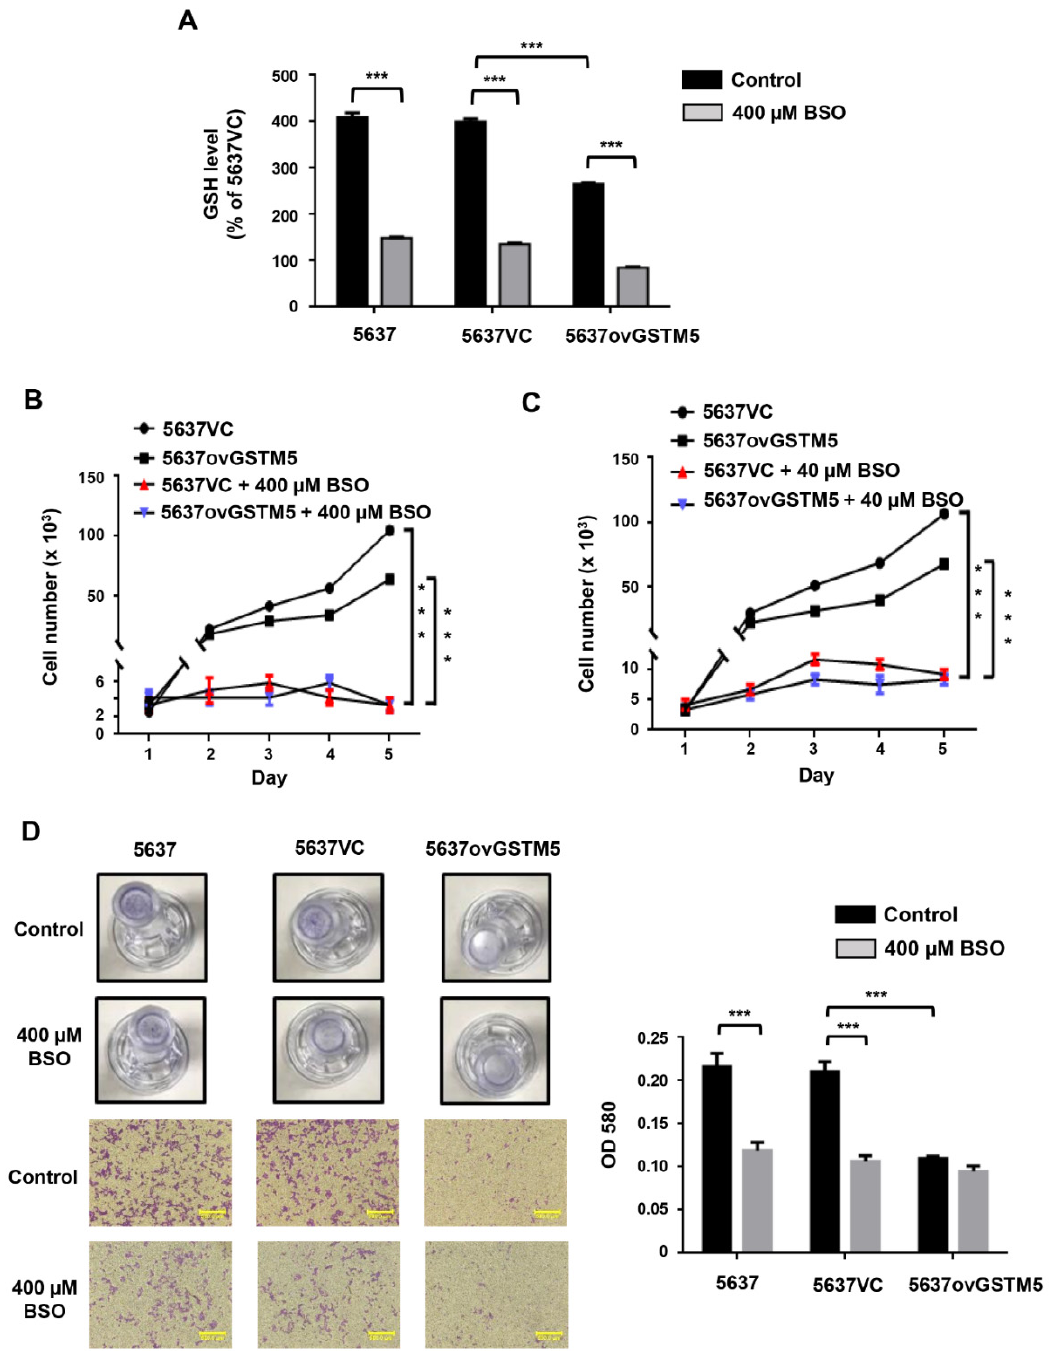
Figure 6. BSO decreased cell migration and proliferation. ( A ) 400 µ M buthionine sulfoximine (BSO) treatment for 24 h decreased the intracellular GSH concentration in cells. ( B ) 400 µ M BSO blocked cell proliferation. The medium was changed once on day 4. ( C ) 40 µ M BSO also decreased cell proliferation. The medium was changed every day. ( D ) Effect of 400 µ M BSO on cell migration of 5637 (left), 5637VC (middle) and 5637ovGSTM5 (right) cells. Upper panel: Transwell insert with a circular membrane of 0.65 cm diameter. Lower panel: microscopic images; scale bar is 500 µ m. All t data are presented as the mean ± SE of three independent experiments. *** p < 0.001.